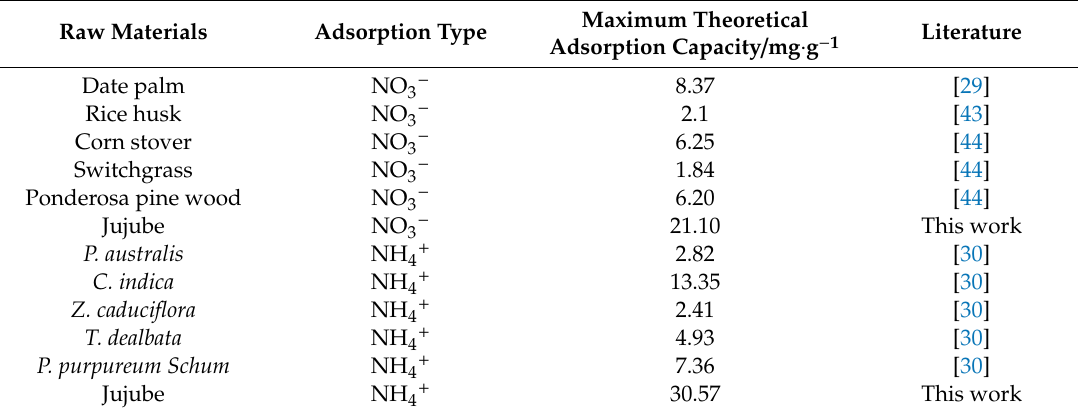
Table 6. Comparison of the adsorption capacity onto various biochars derived from di ff erent